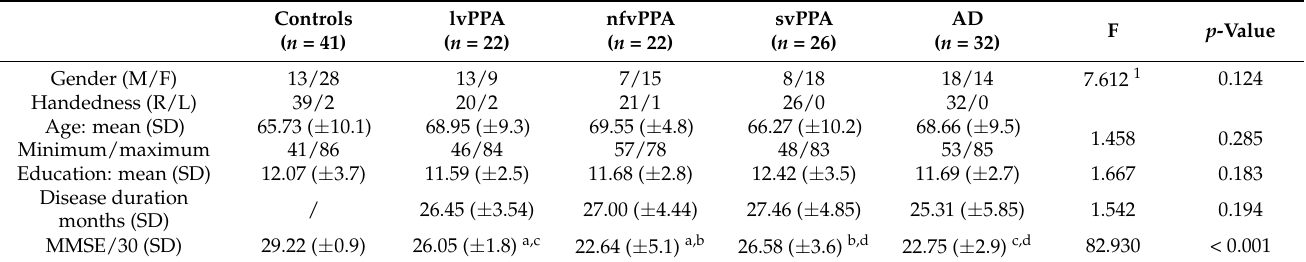
Table 1. Demographic information for controls and PPA